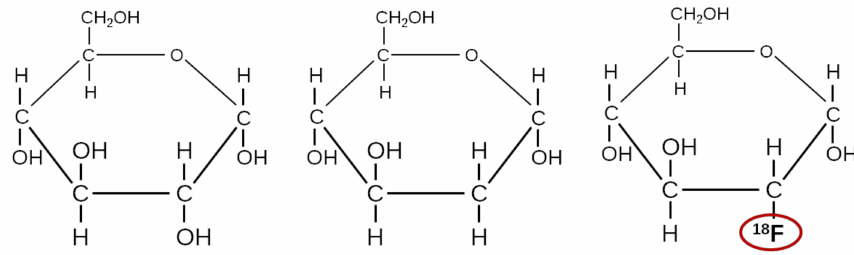
Figure 1. From left-to-right: natural glucose, DG, and [ 18 F]FDG. Both DG and FDG are taken up by cells by the cells’ glucose transporters (GLUTs), but their metabolite products are trapped in the cell. More precisely, glucose, DG, and FDG are all phosphorylated by the glucose-metabolizing enzyme hexokinase. However, while the metabolite product of glucose (glucose-6-phosphate) is further metabolized, the metabo- lite products of DG (DG-6-phosphate) and FDG (FDG-6-phosphate) are not substrates of any enzymes. Furthermore, the cell membrane is very poorly permeable to these interme- diate metabolite products. Thus, for both [ 14 C]DG (for ex vivo radiographic imaging) and [ 18 F]FDG (for in vivo PET imaging), the radionuclide is essentially trapped within the cell. This uptake and trapping of the tracer allow imaging of the glucose metabolism